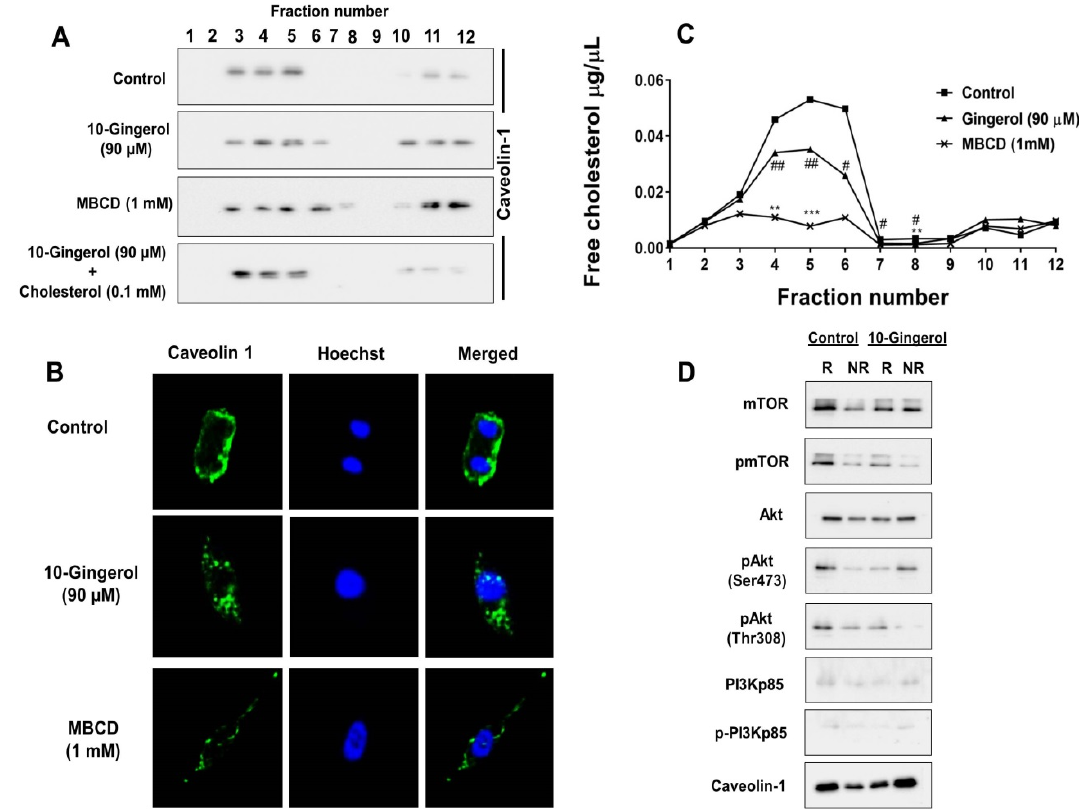
Figure 3. 10-gingerol modulates lipid rafts of MDA-MB-231 / IR cells and displaces rafts-resident PI3K / Akt signaling components: ( A ) Distribution of caveolin-1 in lipid rafts (3–5) and non-raft fractions (10–12) of MDA-MB-231 / IR cells. Following serum starvation, cells were treated with 10-gingerol (90 µ M), 10-gingerol (90 µ M), plus 0.1 mM cholesterol or methyl- β -cyclodextrin (MBCD) (1 mM) for 24 h, and lipid rafts were isolated as described in methods. Following sucrose-density gradient centrifugation, equal volumes (20 µ L) of collected fractions were subjected to Western blot and analyzed using lipid raft marker caveolin-1. ( B ) The presence / distribution of lipid rafts marker caveolin-1 in cell membranes was examined in 10-gingerol (90 µ M) or MBCD (1 mM) treated MDA-MB-231 / IR cells using immunofluorescence. ( C ) Estimation of lipid raft cholesterol levels in 10-gingerol (90 µ M) or MBCD (1 mM) treated MDA-MB-231 / IR cells cultured in serum-starved DMEM. ( D ) Displacement of rafts-resident PI3K / Akt signaling components following 10-gingerol exposure. Lipid raft fractions were isolated from serum-starved MDA-MB-231 / IR cells and, fractions 3–5 (rafts) and 10–12 (non-rafts) were pooled. Proteins were precipitated from 1 mL of pooled sets using methanol and chloroform [31]. The resulted protein pellets were dissolved in equal volumes (50 µ L) of loading bu ff er and subjected to Western blot analysis using the indicated antibodies. * or # p < 0.05, ** or ## p < 0.01 and *** p < 0.001 compared with untreated cells. R: raft fractions and NR: non-raft fractions.